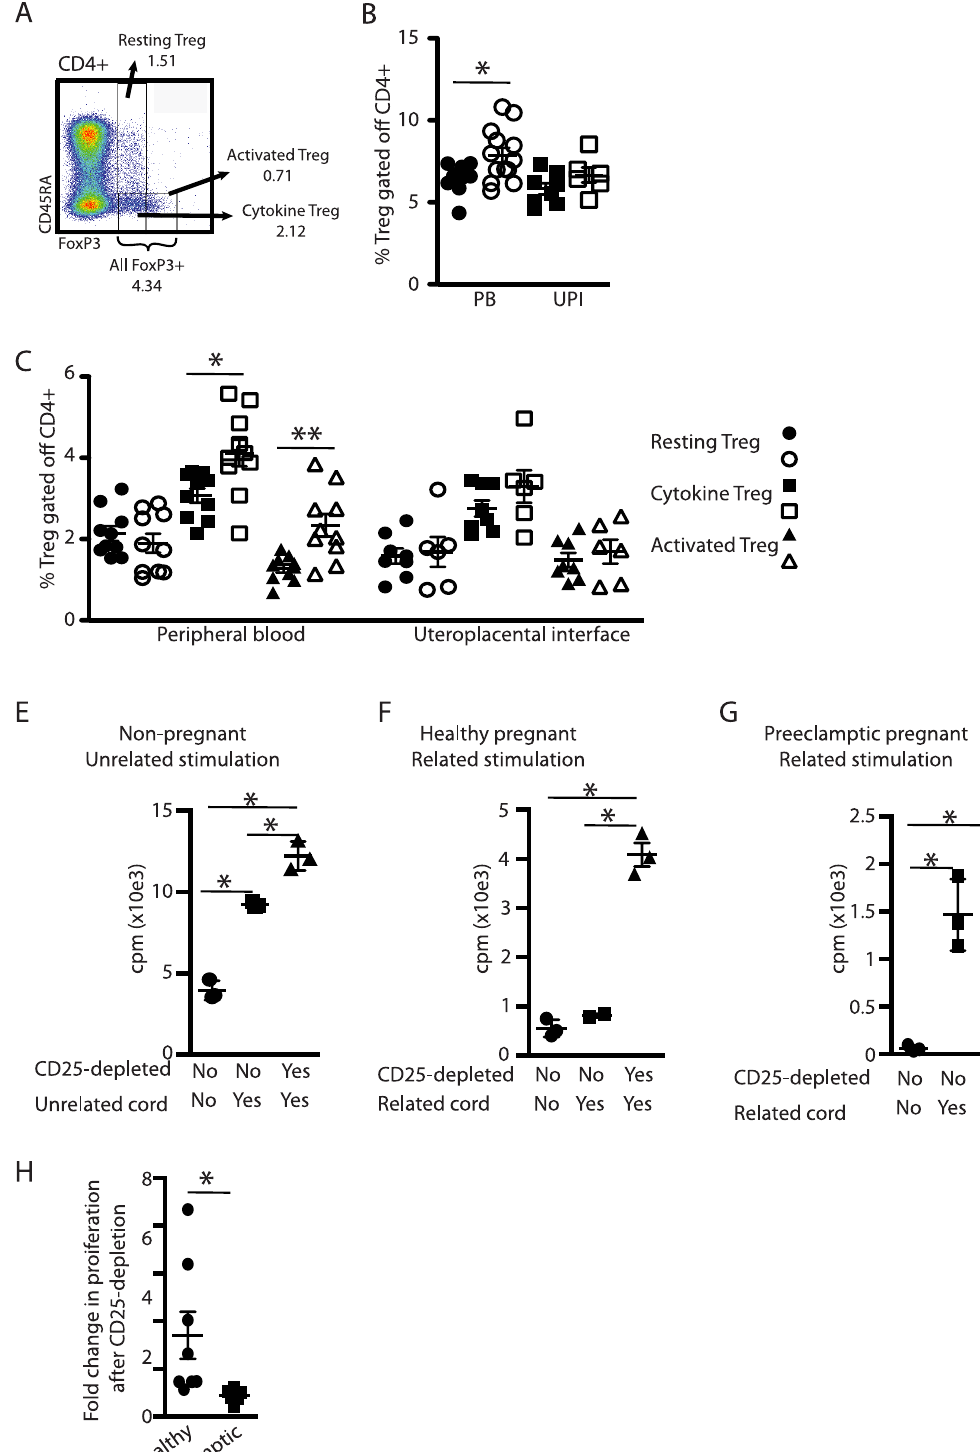
Fig 3. Regulatory T cells of preeclamptic women fail to suppress anti-fetal proliferative responses. (A) Gating strategy for Treg identification. Gating strategy starting with Fig 1B lymphocyte gate and subjectingto S1A Fig Steps until identificationof CD4+ T cells. (B) Proportionof total FoxP3+ Treg gated off the total CD4+ populations. (C) % of